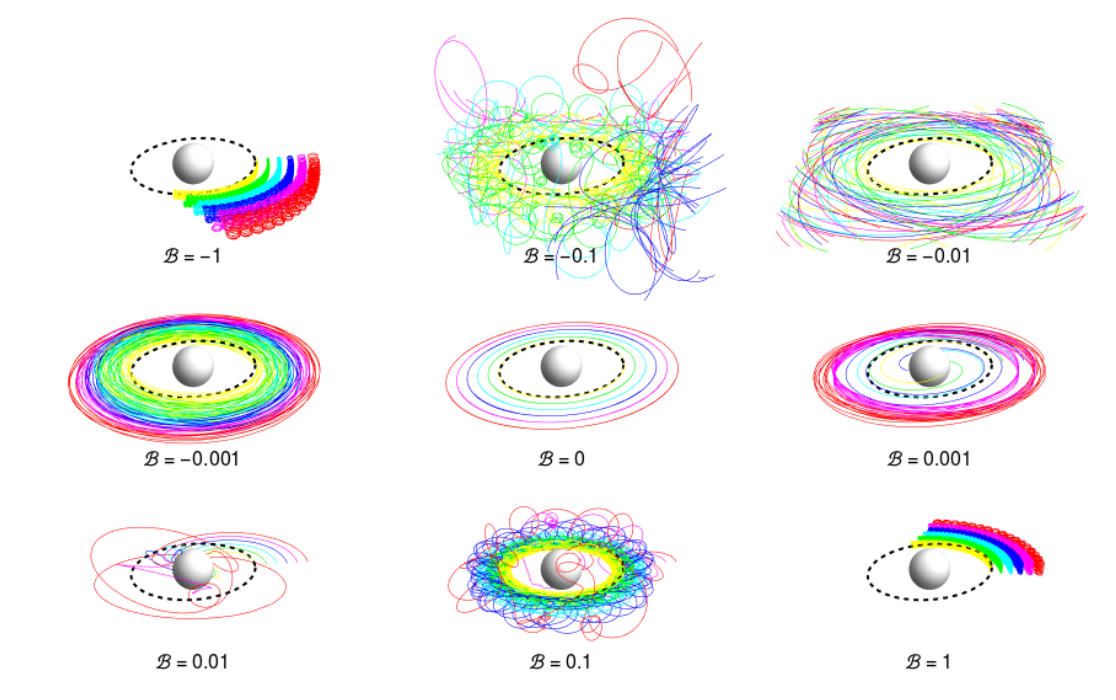
Figure 7. Thin Keplerian accretion disk around Schwarzschild BH in dipole magnetic field. and its evolution after ionization. The disk is located closely to the equatorial plane of the background. The dependence of the fate of the ionized disk on the intensity of the electromagnetic interaction (magnetic parameter) is generally in concordance with the case of the uniform magnetic field.